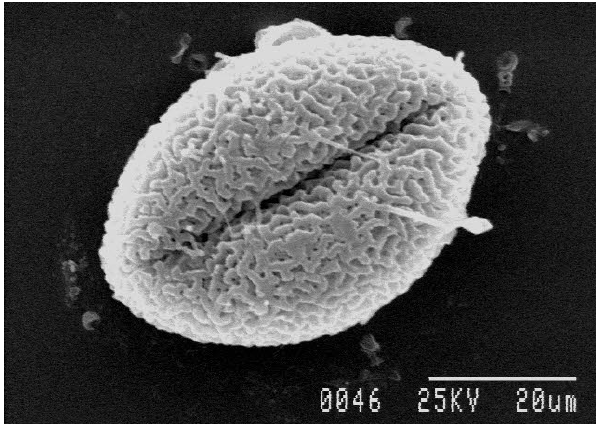
Fig. 3. X1500, showing monosulcate pollen of Nelumbo nucifera Gaertner